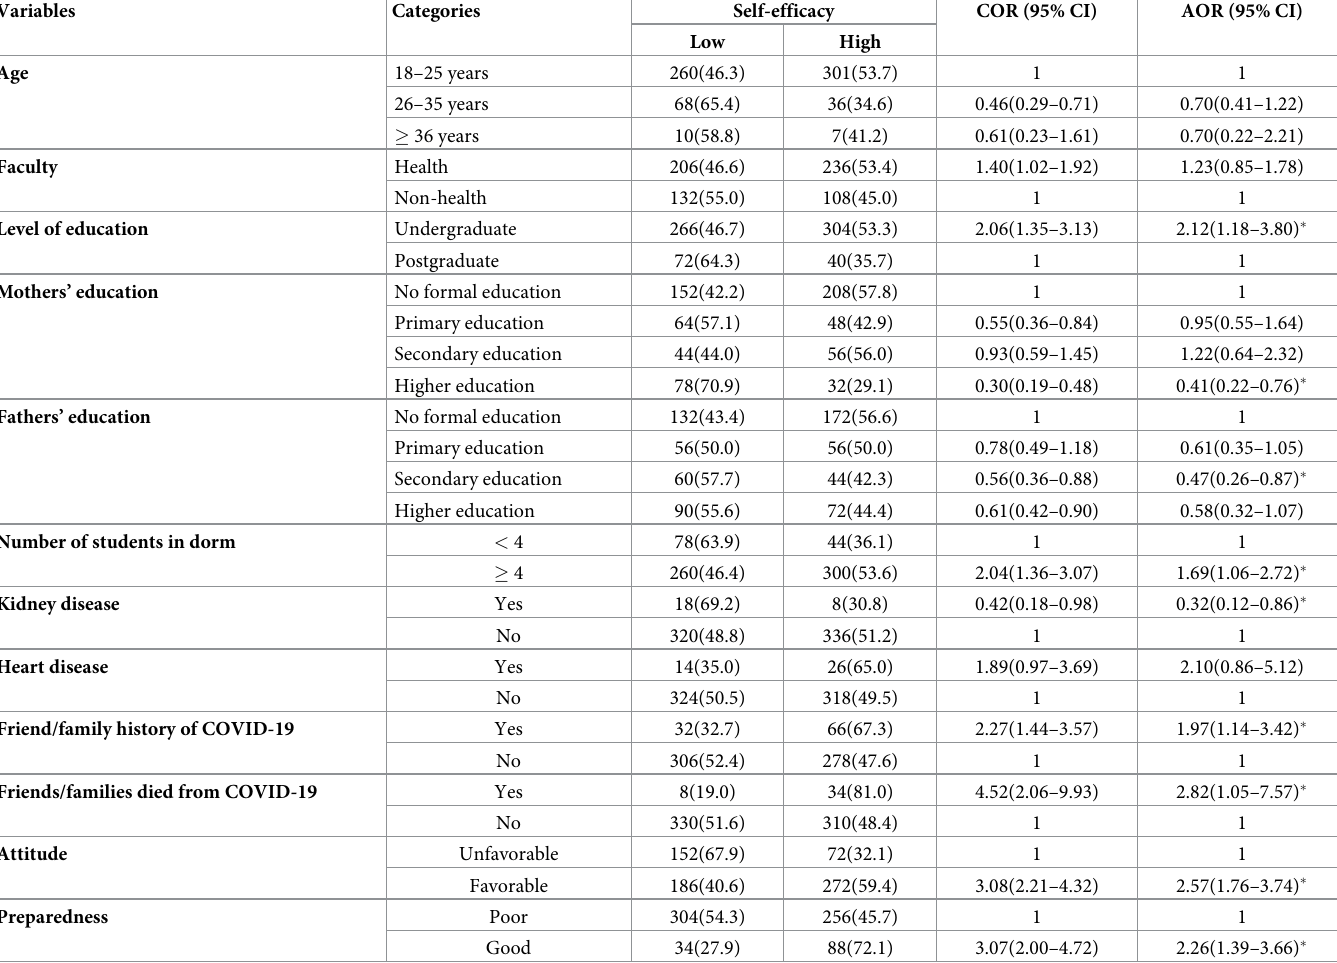
Table 8. Univariable and multivariable logistic regression analysis for perceived self-efficacy in controlling COVID-19 pandemics in DBU, Northeast Ethiopia,